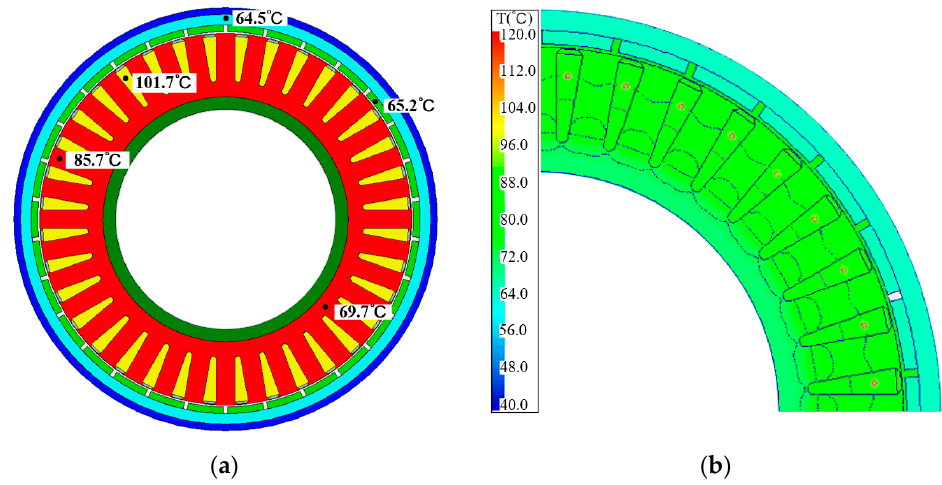
Figure 19. The core loss and eddy current loss of PM in final scheme: ( a ) core loss; ( b ) eddy current loss of the PM.